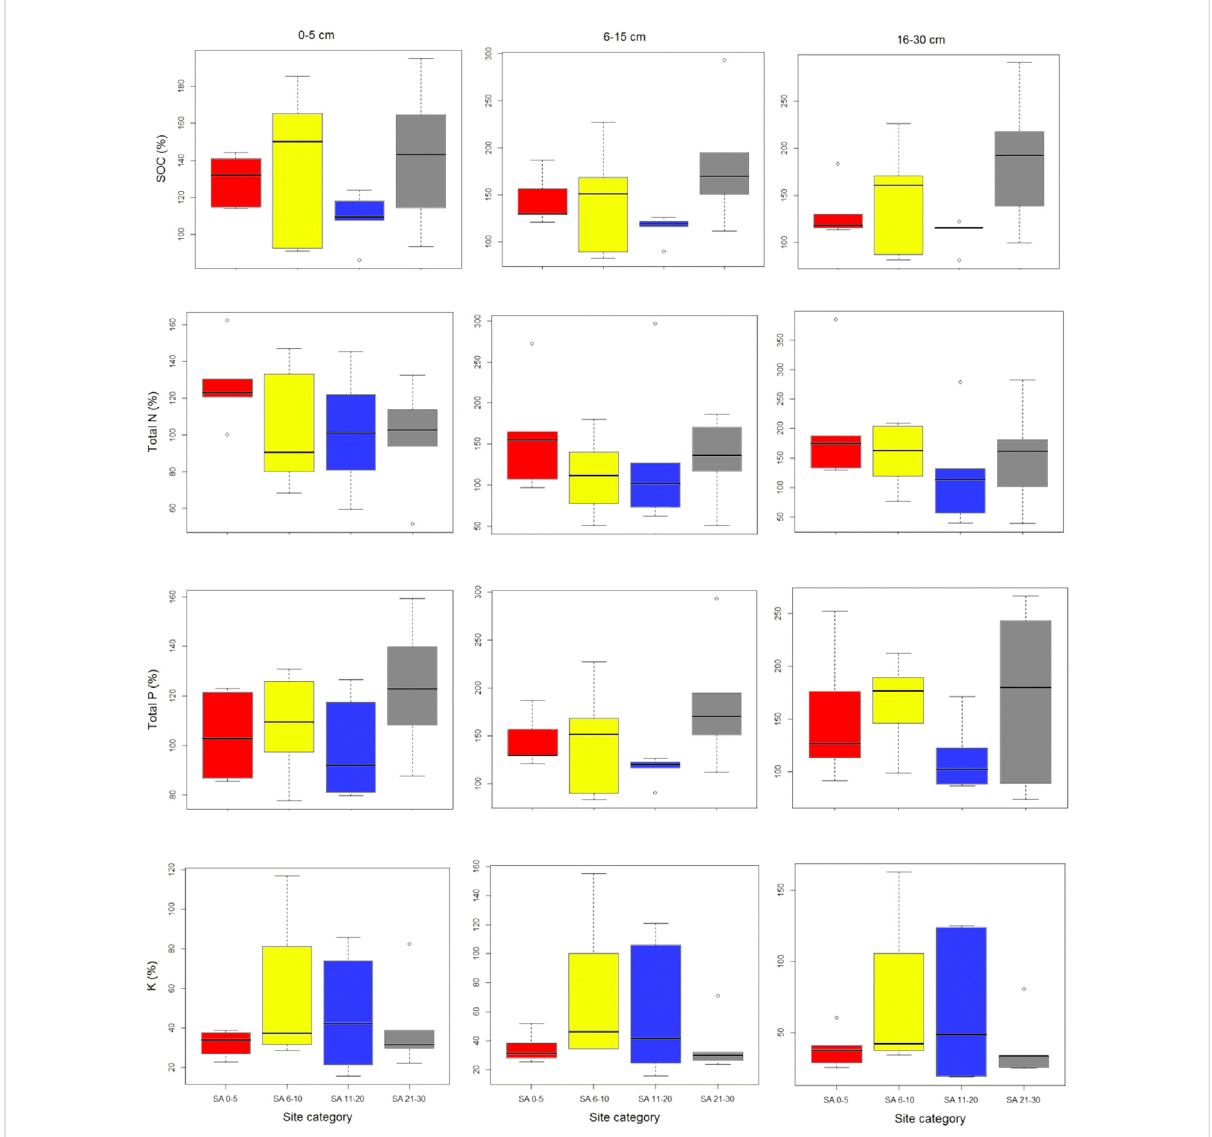
FIGURE 3 Recovery of soil carbon and nutrients at our study sites on Leyte Island, the Philippines. Note that different scales are used on the Y